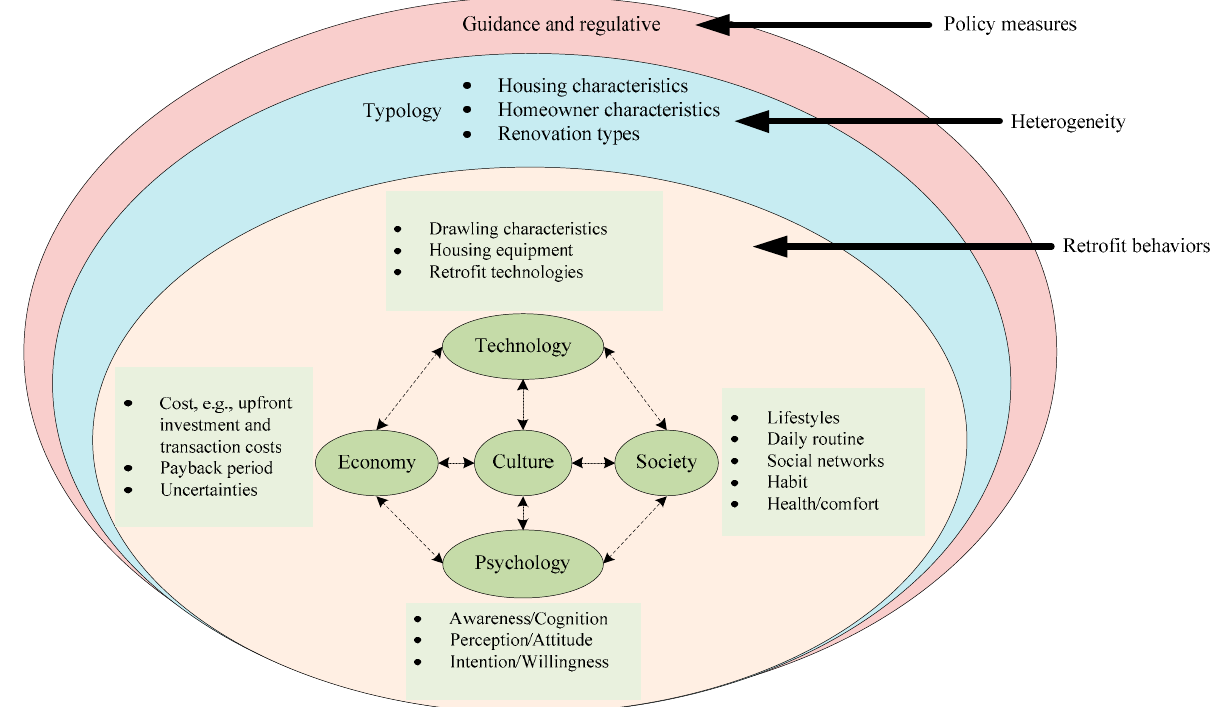
Figure 4. The integrative research framework of multiple domain-specific findings. •